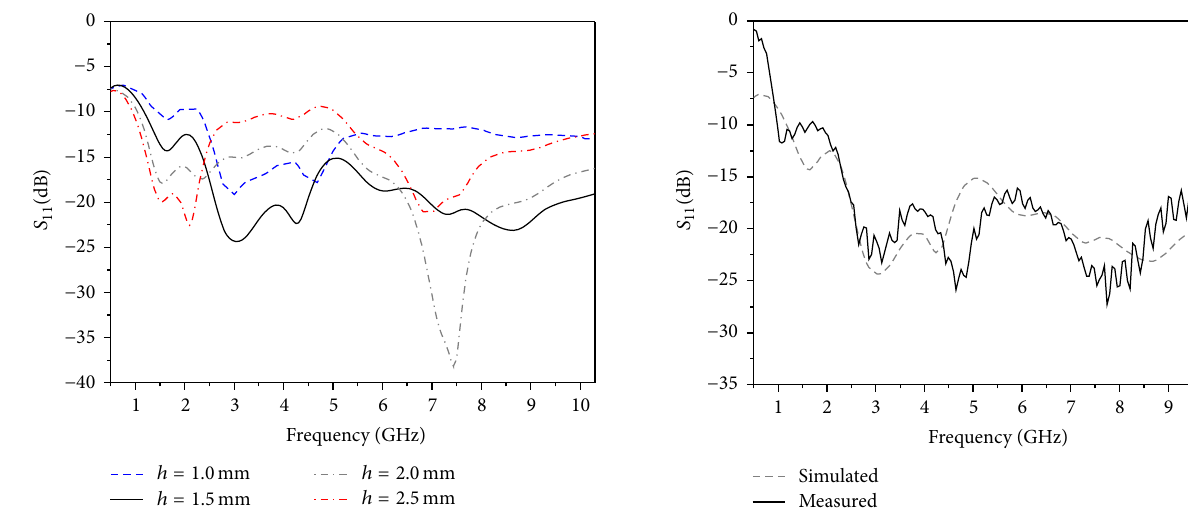
Figure 8: Measured and simulated input return loss of proposed